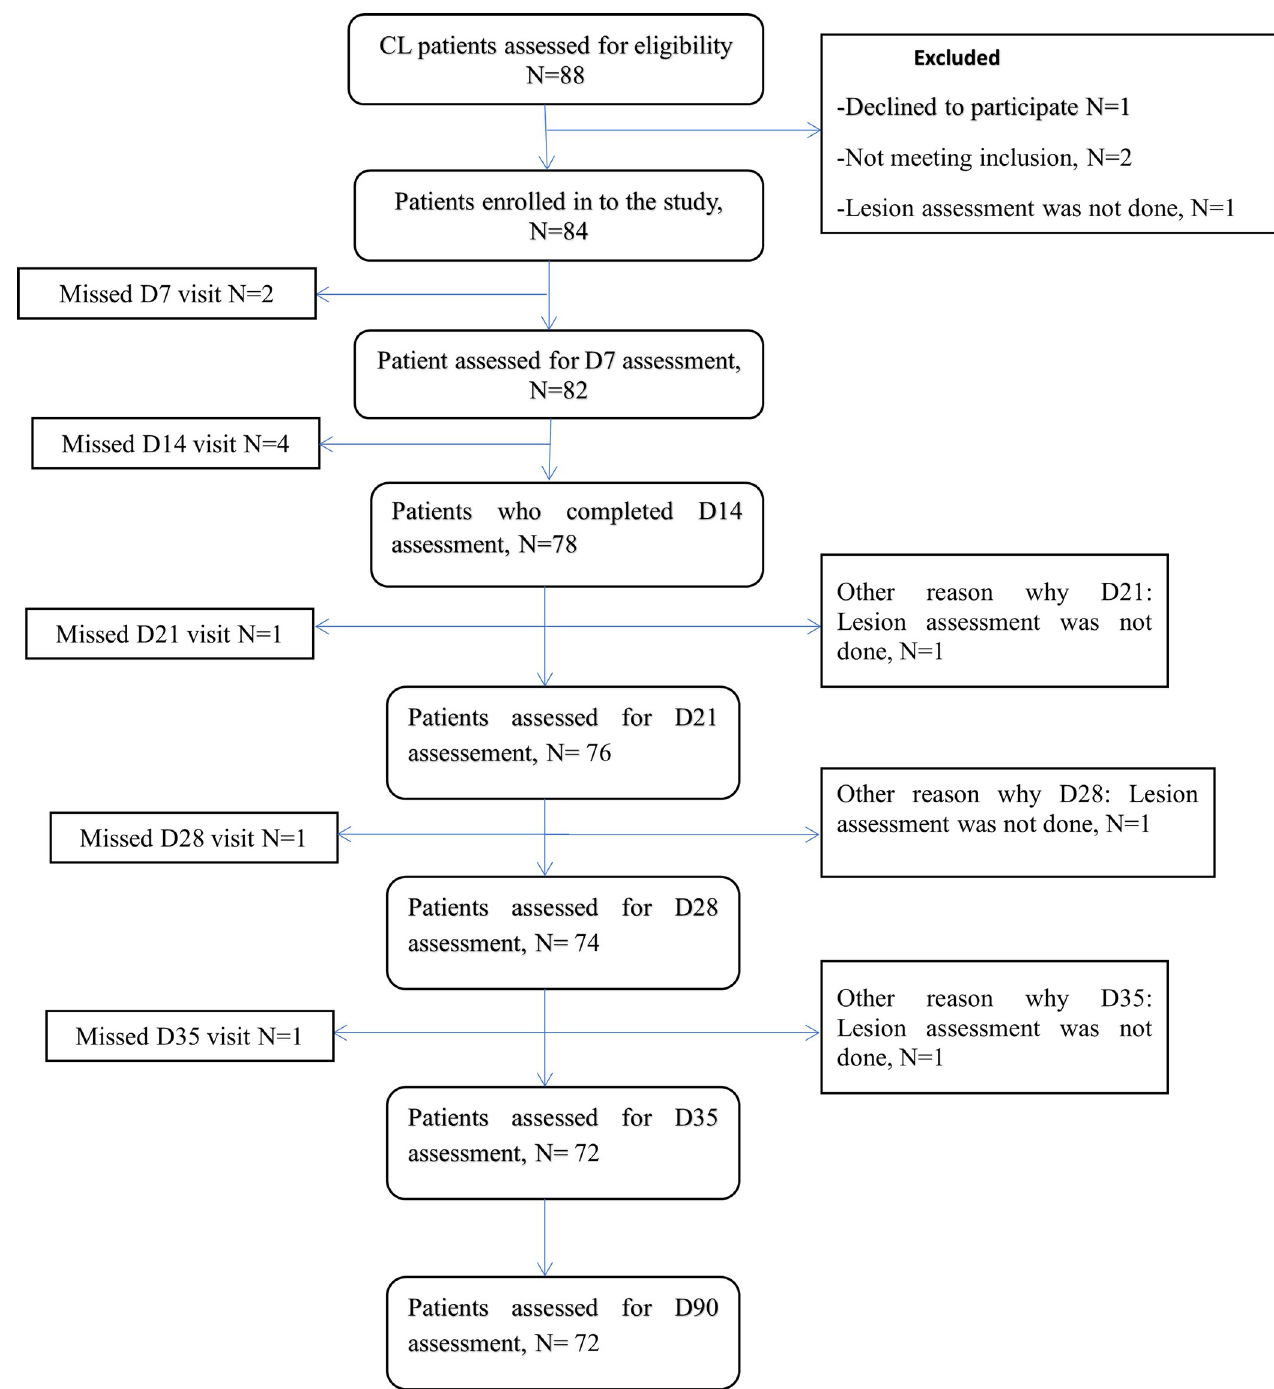
Fig 1. LCL IL SSG treatment assessement flow chart, Boru Meda General hospital, 2021 https://doi.org/10.1371/journal.pntd.0010578.g001 The median size of the lesion was 3cm (IQR 3.2 ± 1.0). Twenty (27.8%) of the patients’ index lesion was smaller than 4cm. More than half (40, 55.6%) of the patients had a single lesion and 27 (37.5%) of the patients had an index lesion found on the face.